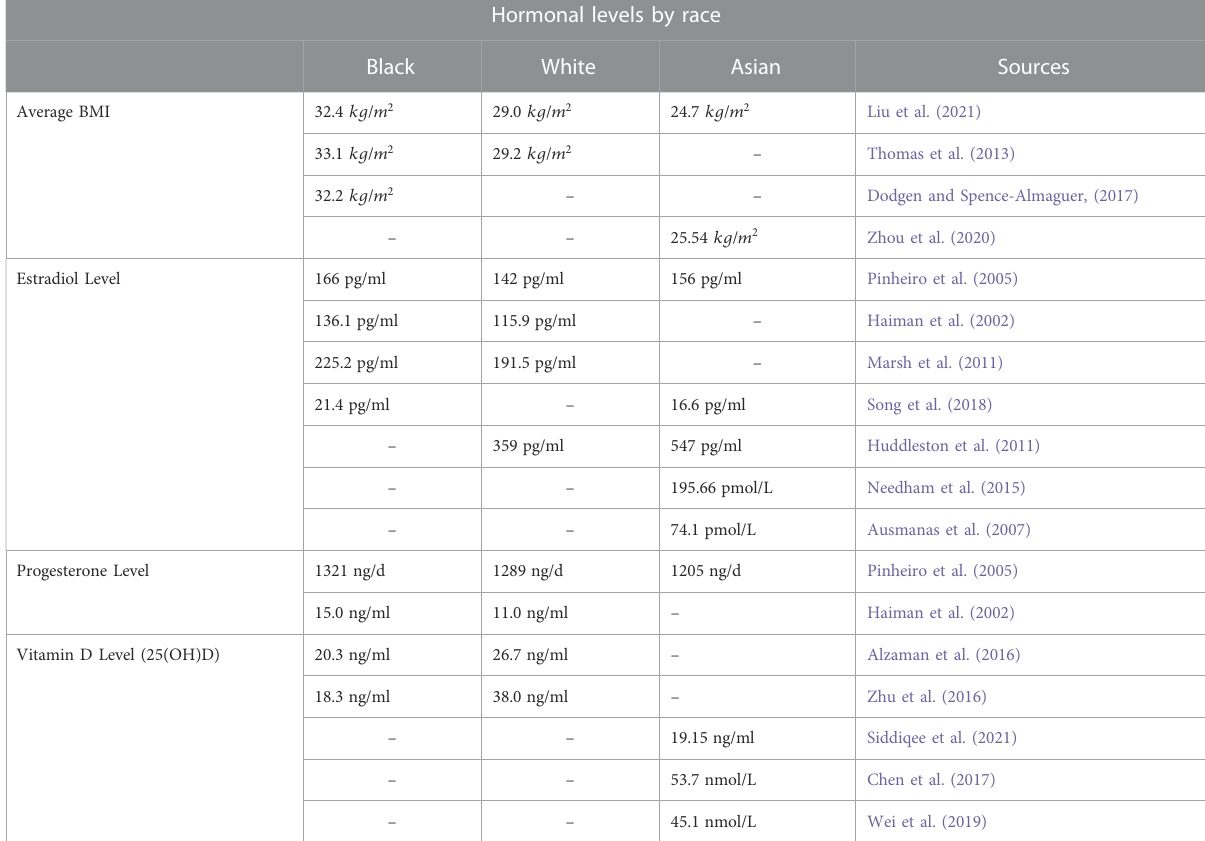
TABLE 3 BMI and hormonal levels by